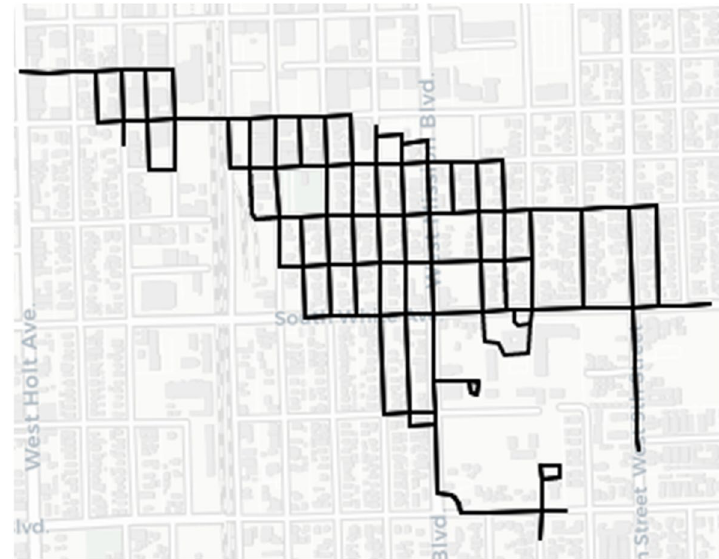
Fig. 4 Overview of the portion of the road network of Pomona, California that is